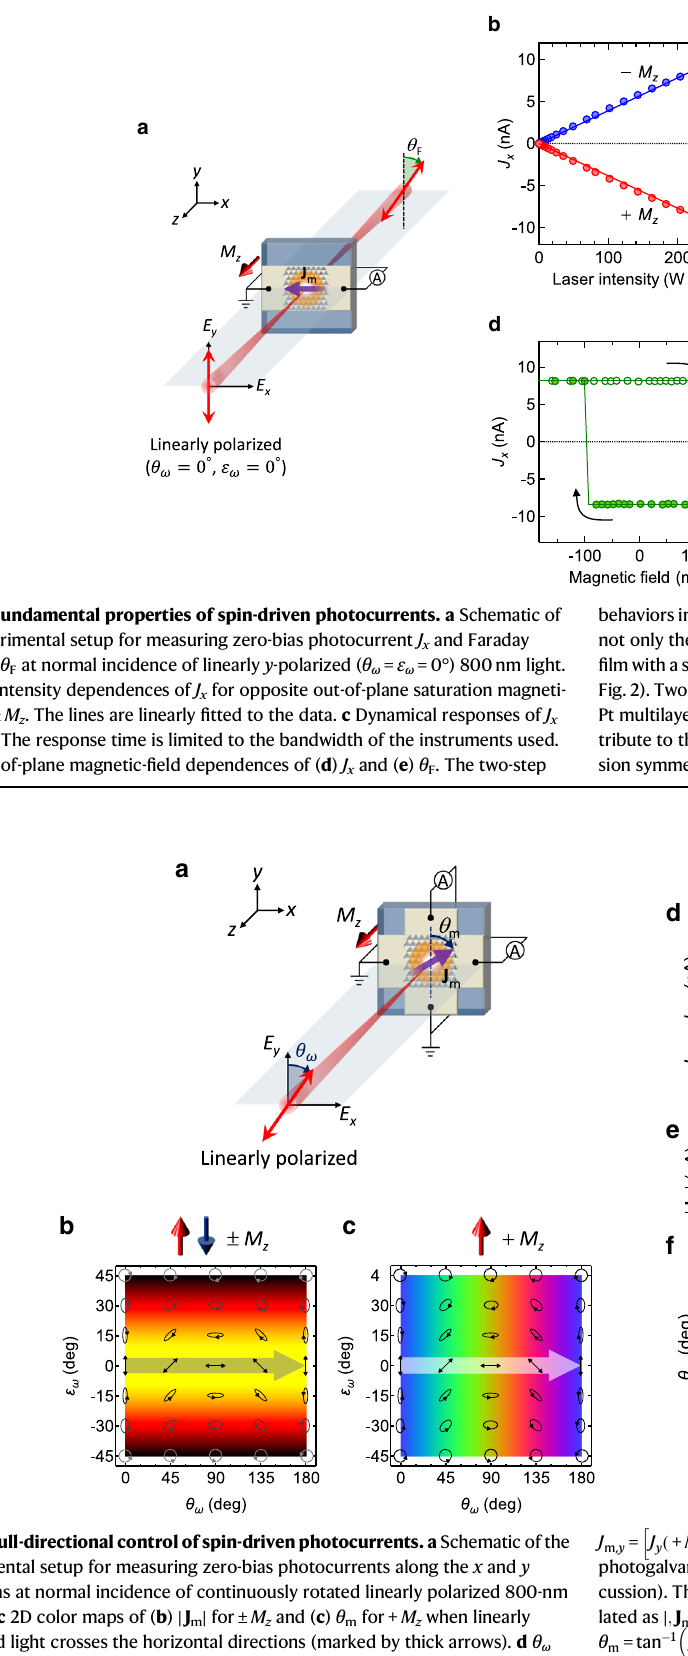
Nature Communications| (2022)